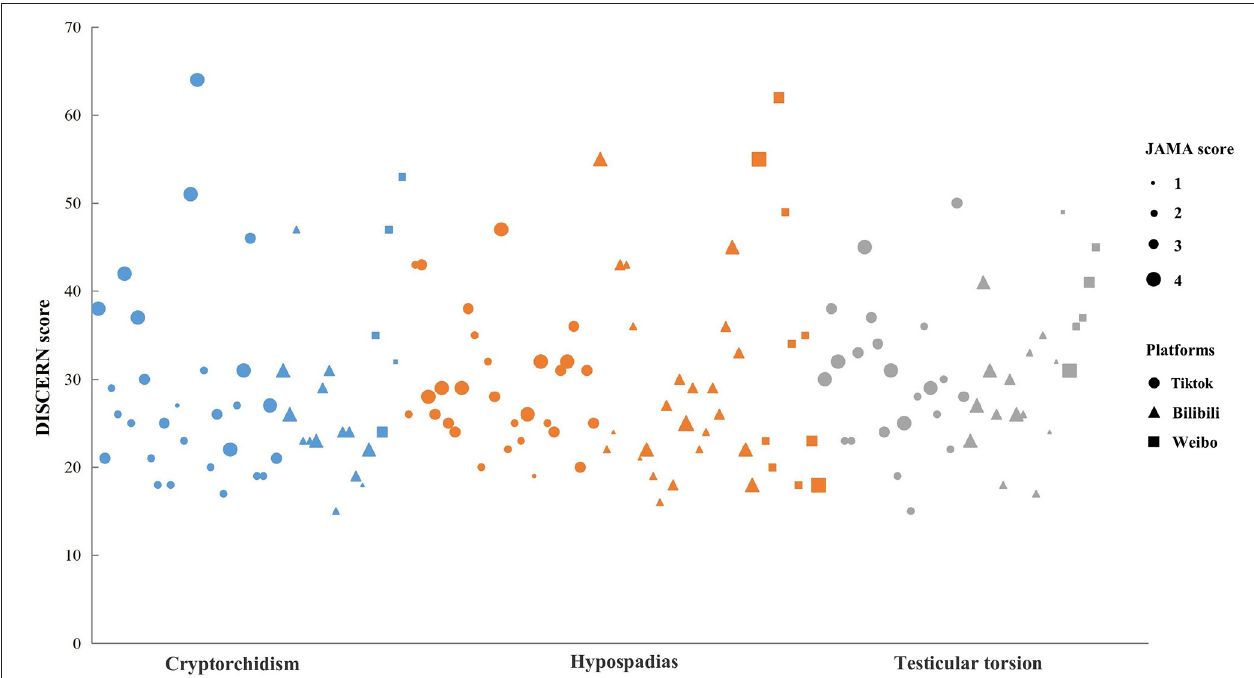
FIGURE 2 | Detailed results of DISCERN and JAMA scores of each included video.